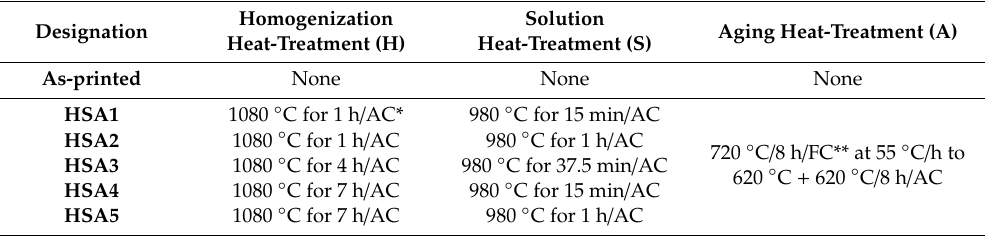
Figure 3. ( a ) Schematic representation of the entire heat-treatment cycle of the laser powder bed fused IN718 in the present study; ( b ) schematic drawing illustrates the position of the homogenization and solution treatment conditions inside the post-treatment time window. Table 2. Designations of specimens and the details of the corresponding post-treatment conditions.